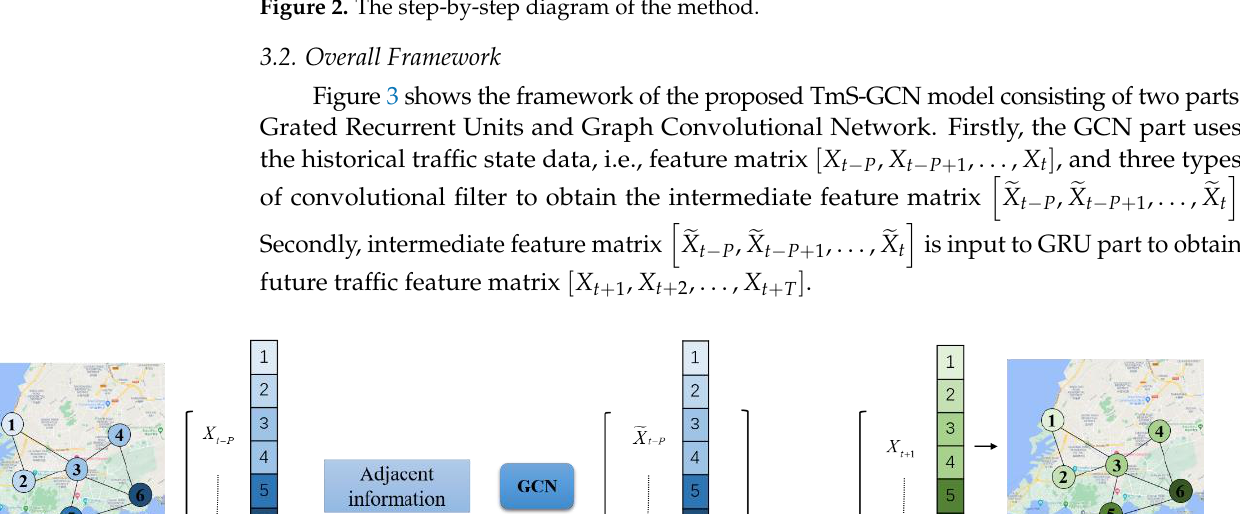
Figure 2. The step-by-step diagram of the method.